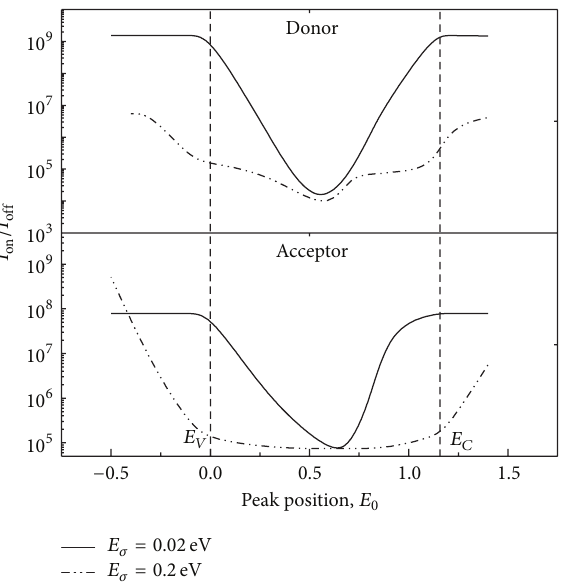
/𝐼 versus the peak position of high and low distribution ITs for DG-TFET. on off